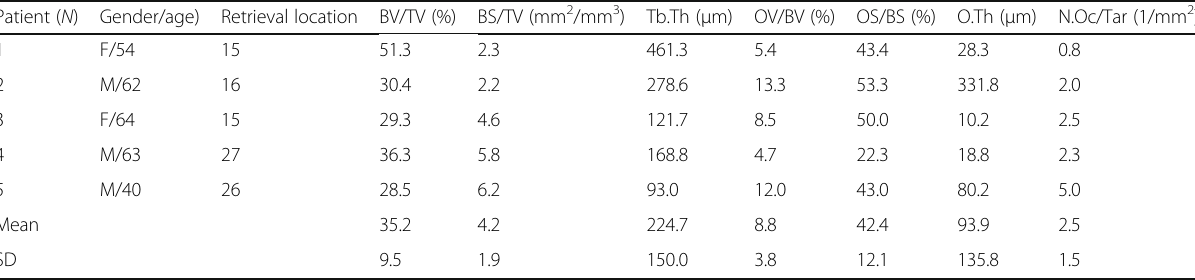
Table 3 Histomorphometric evaluation of the biopsies after a 9-month healing time